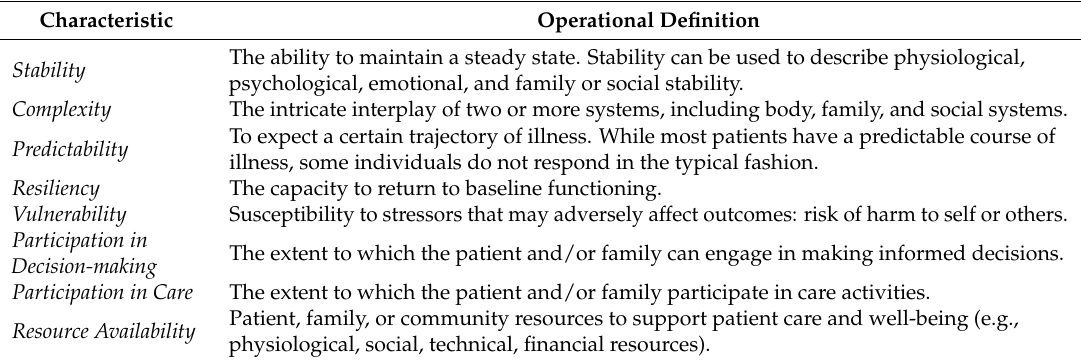
Table 1. The Eight Synergy Tool Patient